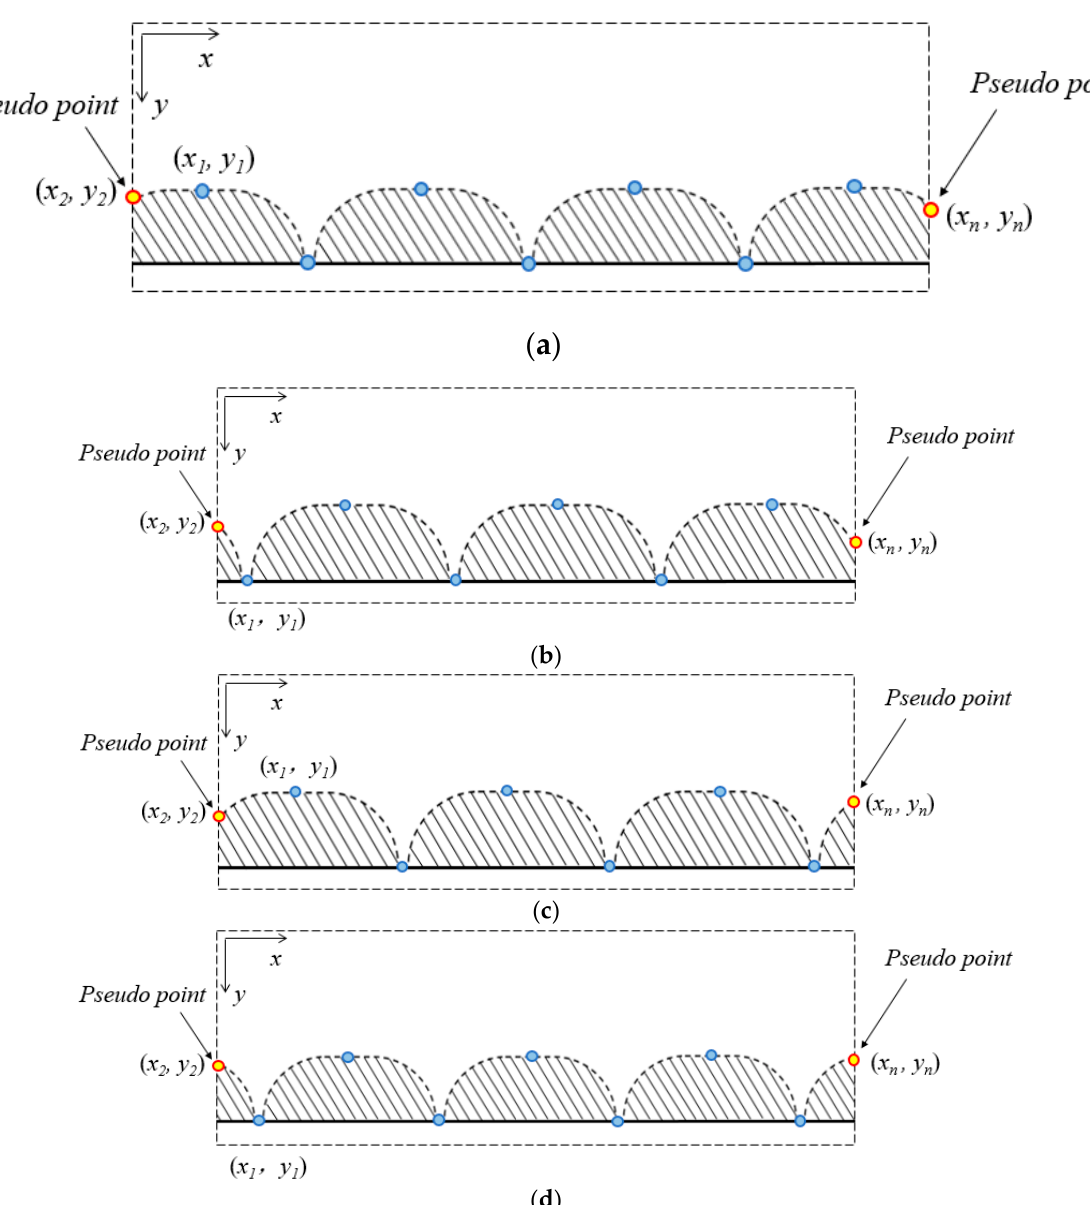
Figure 18. Establish four models of traverse profile: ( a ) W-type; ( b ) N-type; ( c ) inv-N-type; ( d ) M-type. 5. Determine the coordinates of the intersection point. Connect the neighboring peak and valley coordinate points, and find the mid-slope of each line, each adjacent two mid-slope lines will intersect to form the intersection, such as a certain valley-to-peak line of the mid-slope can be expressed by the point-slope of the position of the coordinate point ( k 1 , x 1 , y 1 ), k 1 is the slope, and the adjacent peak to valley line of the mid-slope of the point-slope expressed as ( k 2 , x 2 , y 2 ), calculate the two mid-slope line of intersection point formula is: